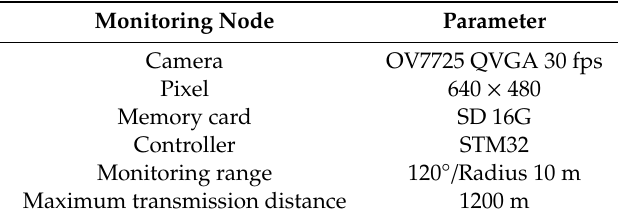
Table 1. Parameters of the wireless multimedia sensor network (WMSN) node.